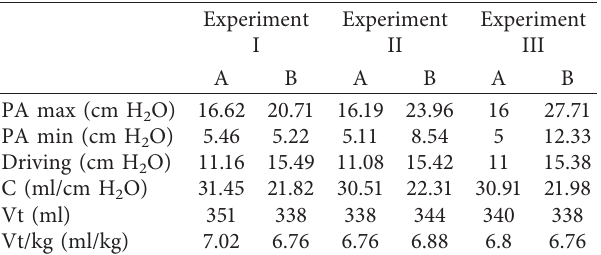
Table 5: Stage 2 in VCV. Experiment